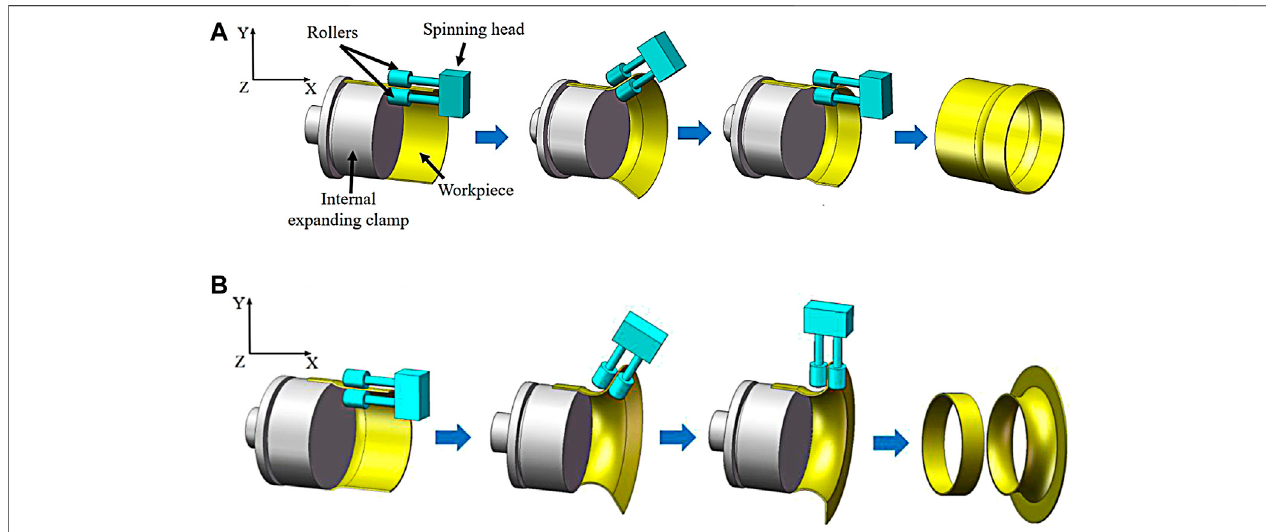
FIGURE 3 | (A) DRCS process for the contraction segment of a wind concentrator. (B) DRCS process of the expanding segment and vortex forming section of a wind